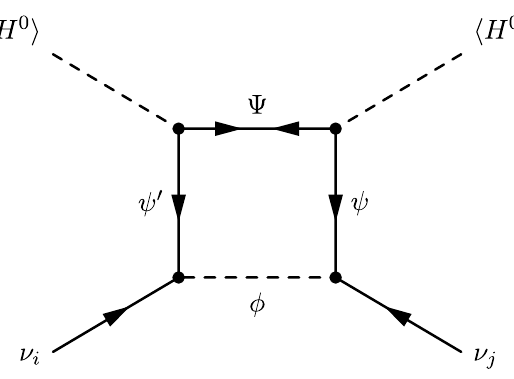
Figure 1 . Loop topology T1-3 for the radiative generation of neutrino masses at the one-loop level. Field Generations Spin Lorentz rep.